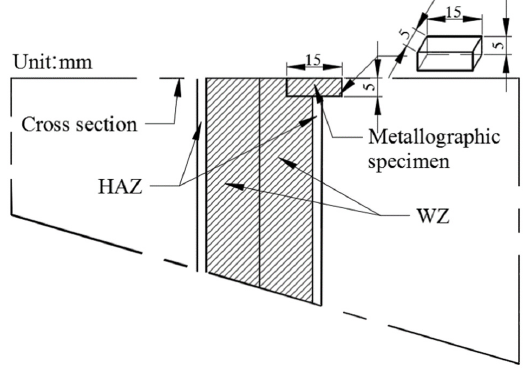
Figure 2. Sampling diagram of metallographic sample .